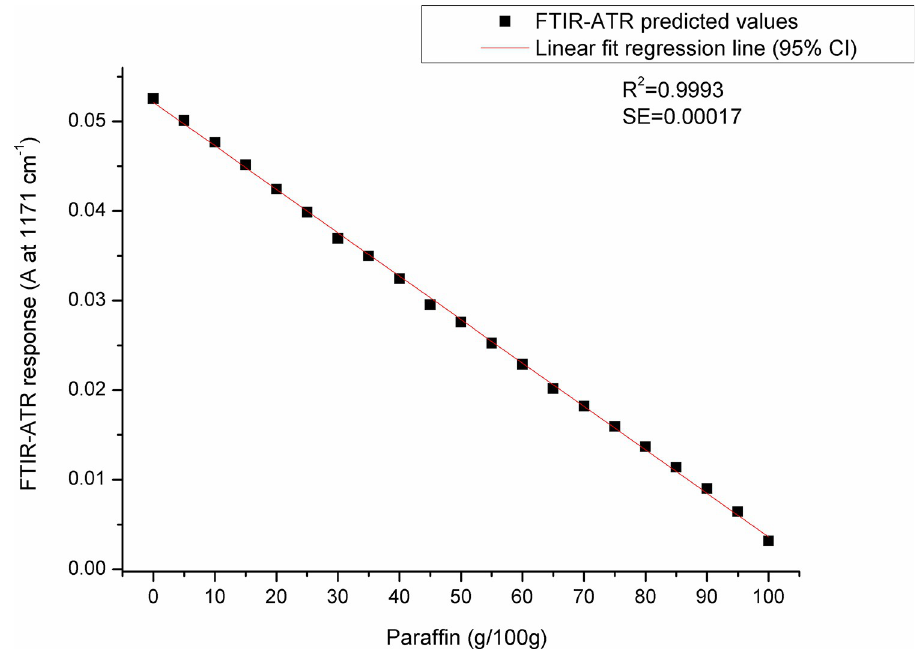
Fig 7. A scatter plot of FTIR-ATR predicted values (instrument response) versus real (known) paraffin share values using the spectral region with an absorption maximum at 1171 cm -1 .